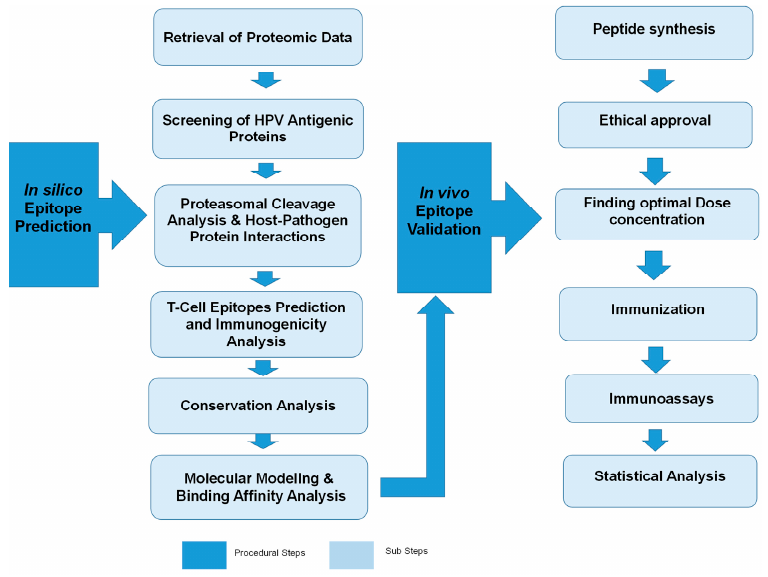
Figure 8. Framework of our methodology for designing potential epitopes of human papilloma virus (HPV). Table 2. List of tools, databases and software used in this